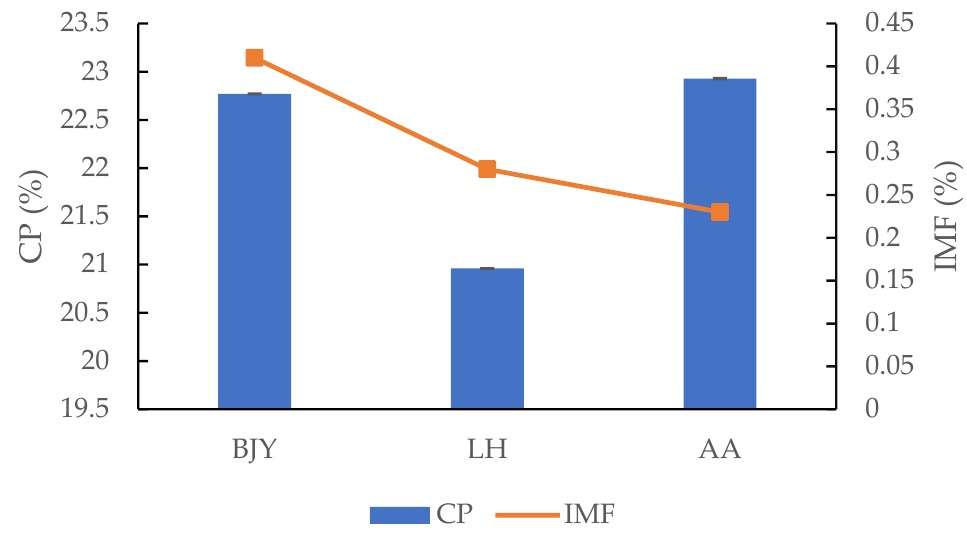
Figure 2. IMF and CP contents of different breeds of chicken breast.